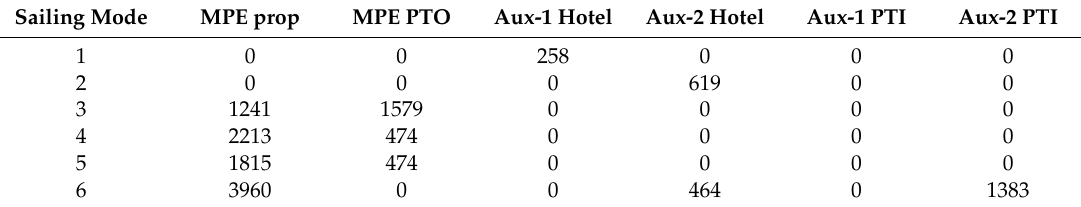
Table 7. Cargo ship: MILP unit scheduling.